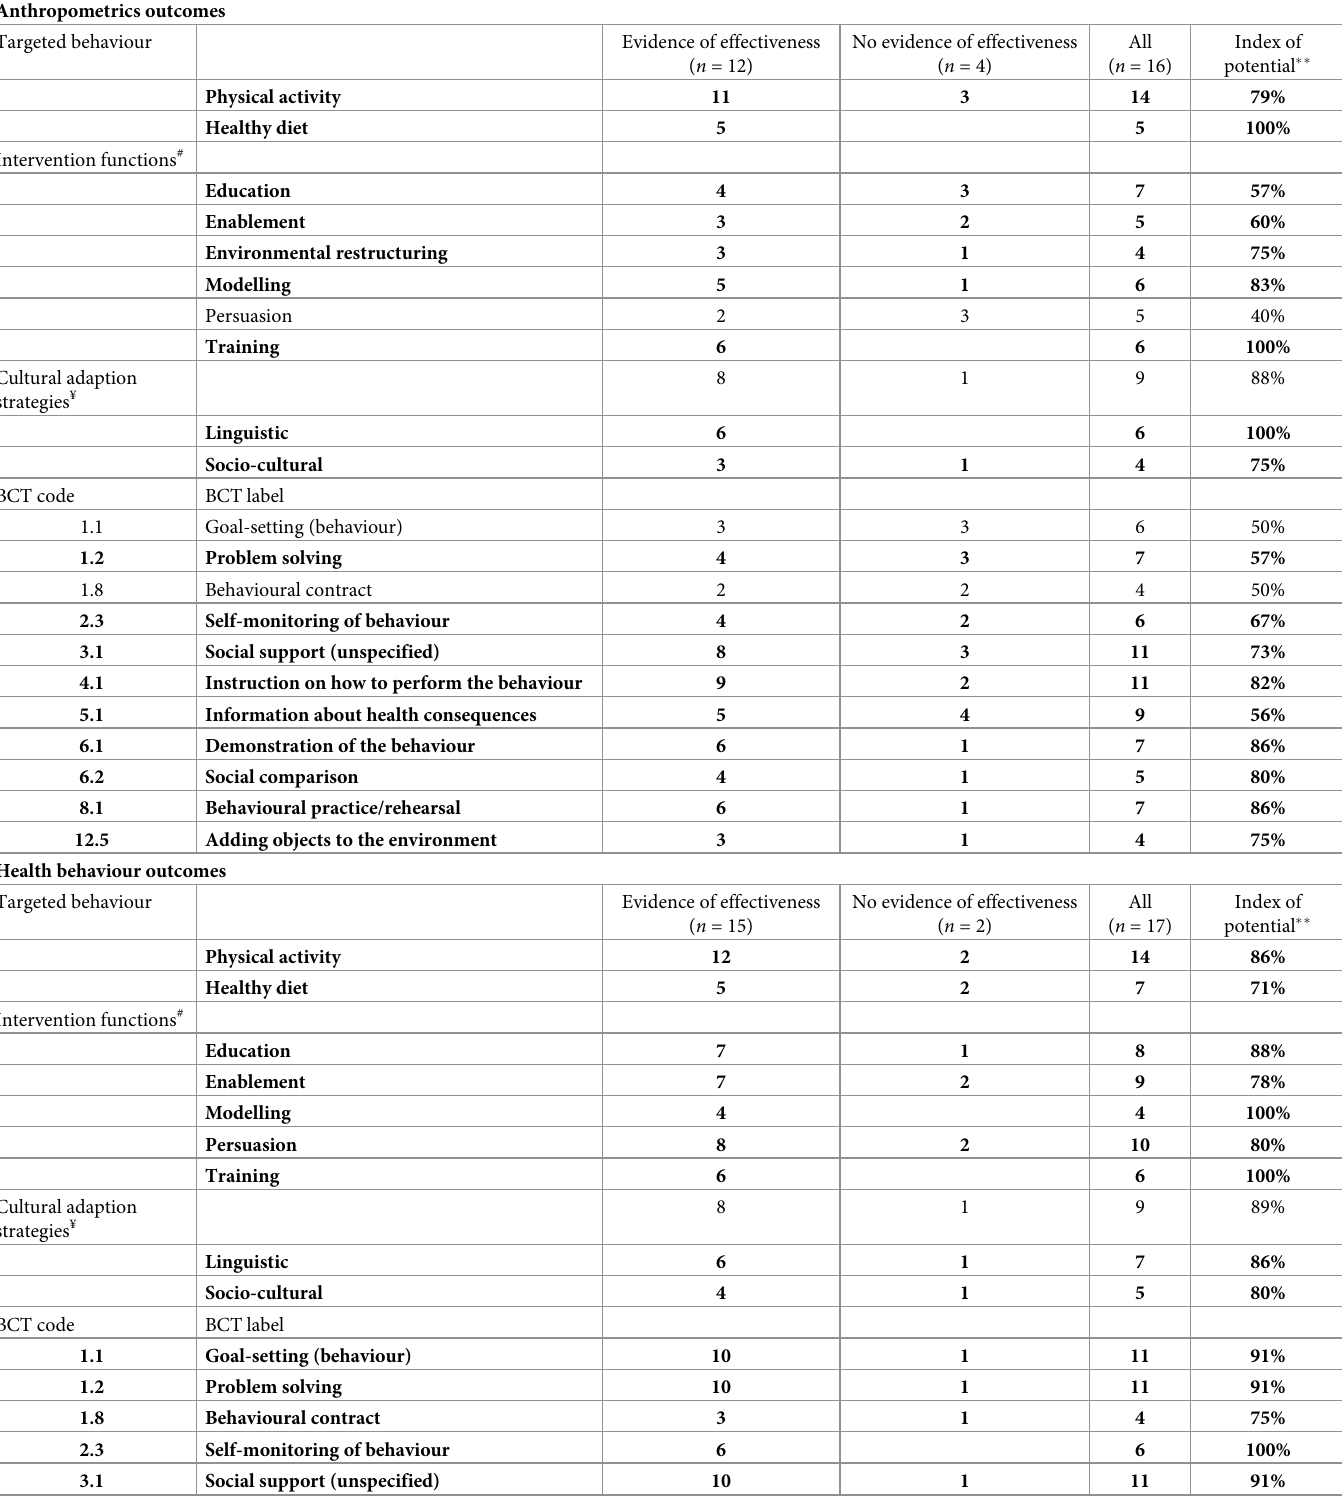
Table 2. Intervention effectiveness by outcome cluster � . Anthropometrics